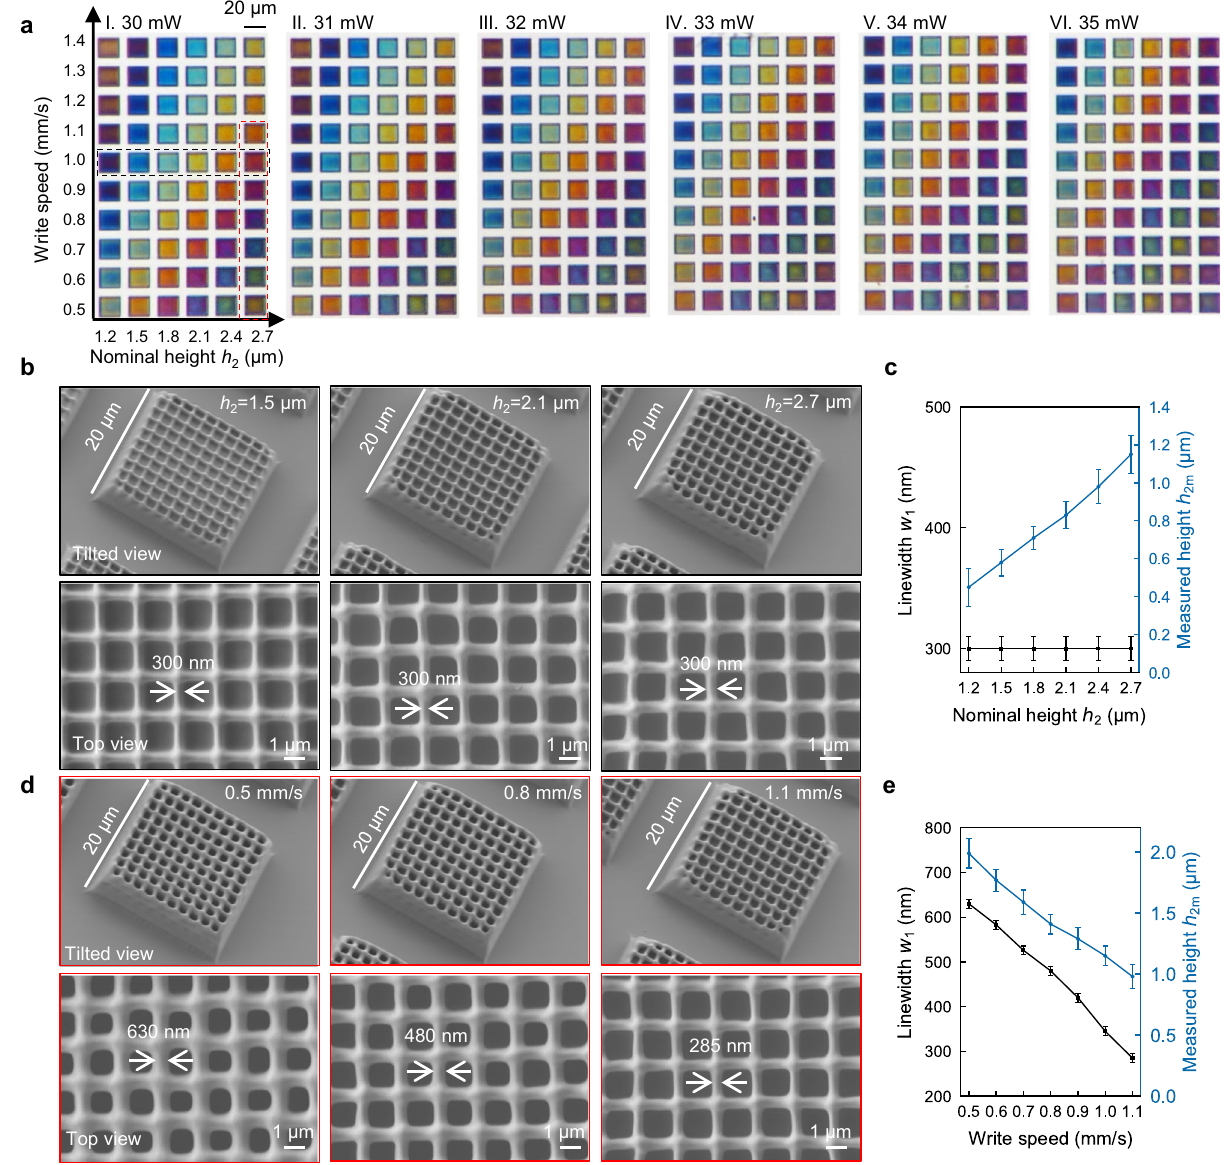
Fig. 2 Optical and scanning electron micrographs (SEM) of as-printed structures. a Optical transmittance micrographs of a printed colour palette for a constant pitch of 2 μ m but varying write speed and nominal height h 2 for a range of laser power (I – VI laser power 30 – 35 mW respectively). b SEM images of grid structures with different nominal height h 2 for constant write speed of 1 mm/s and laser power of 30 mW. c Measured grid linewidth w 1 and height h 2m as a function of nominal height; d SEM images for grid structure with different write speeds for 30 mW. e Measured grid linewidth and height as a function of write speed. Values in c and e represent mean and the error bars represent the standard deviation of the measured values ( n =